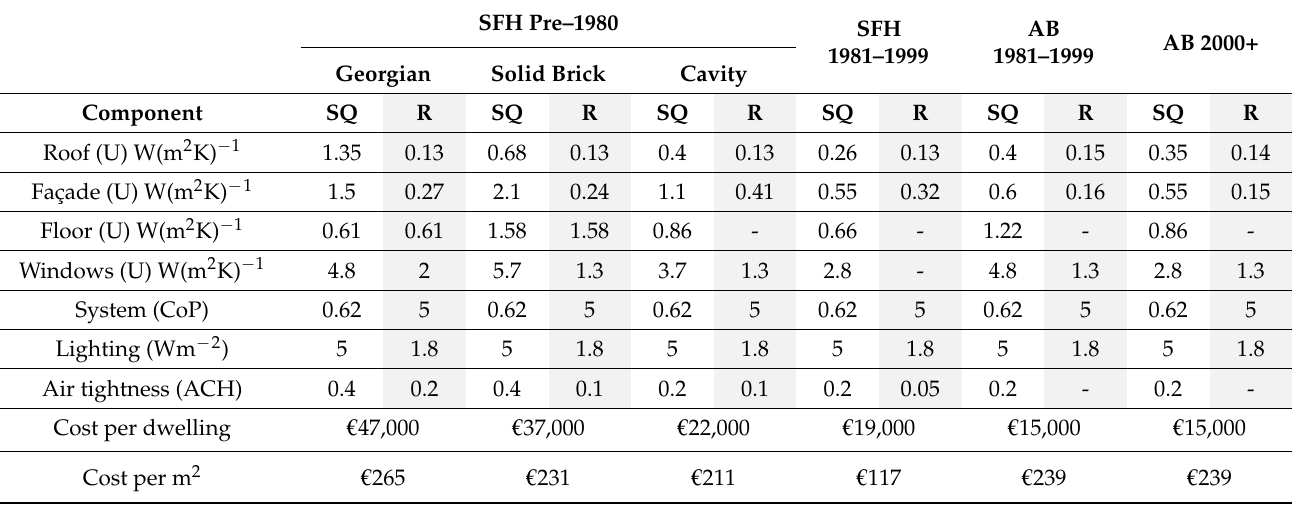
Table 3. Parameter values for components of buildings before status quo (SQ) and after retrofit (R) modifications and estimated cost per dwelling based on size. The default system used to heat the dwelling is a heat pump. For solid wall buildings and apartments, external wall insulation is applied. All costs and associated EUIs for each measure are derived from the Tabula webtool and associated literature linked below (https://episcope.eu/fileadmin/tabula/public/docs/brochure/IE_TABULA_TypologyBrochure_EnergyAction.pdf) (accessed on 20 February